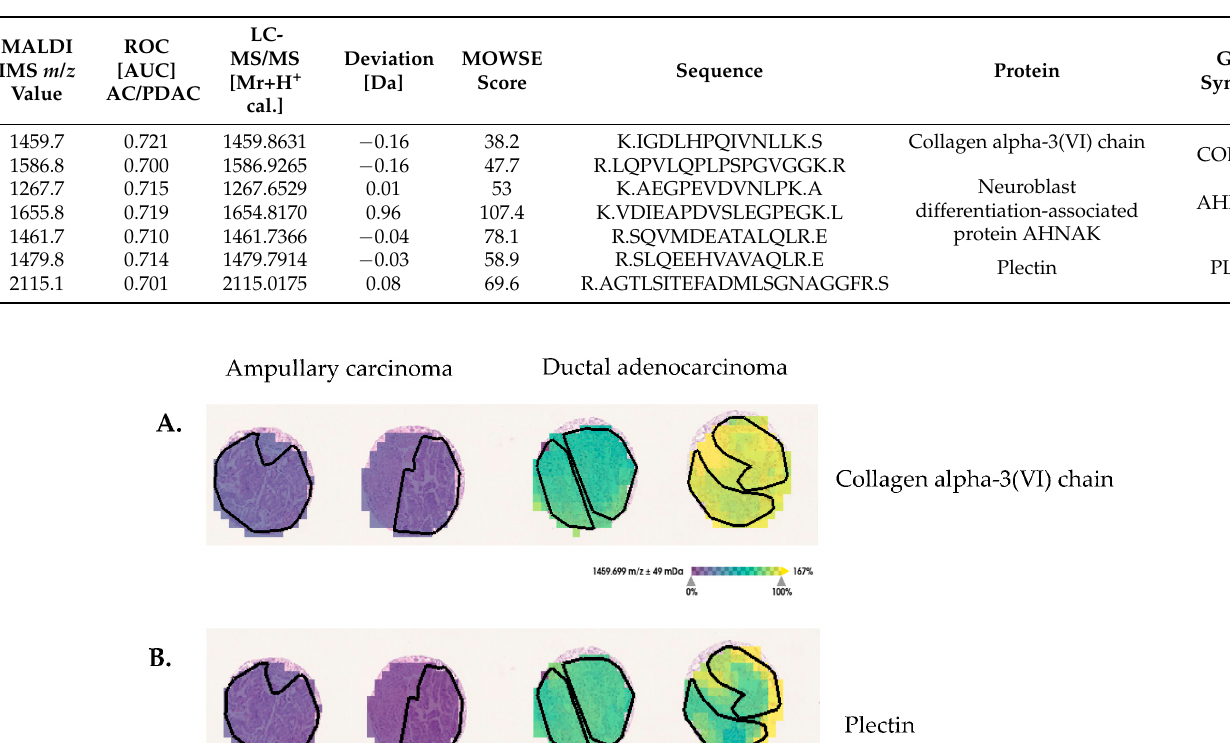
Table 4. Differential intensity distributions of m / z values (MALDI-MSI) and their corresponding proteins in tissue sections from pancreatic ductal adenocarcinoma and ampullary carcinoma tissue (tumor regions).